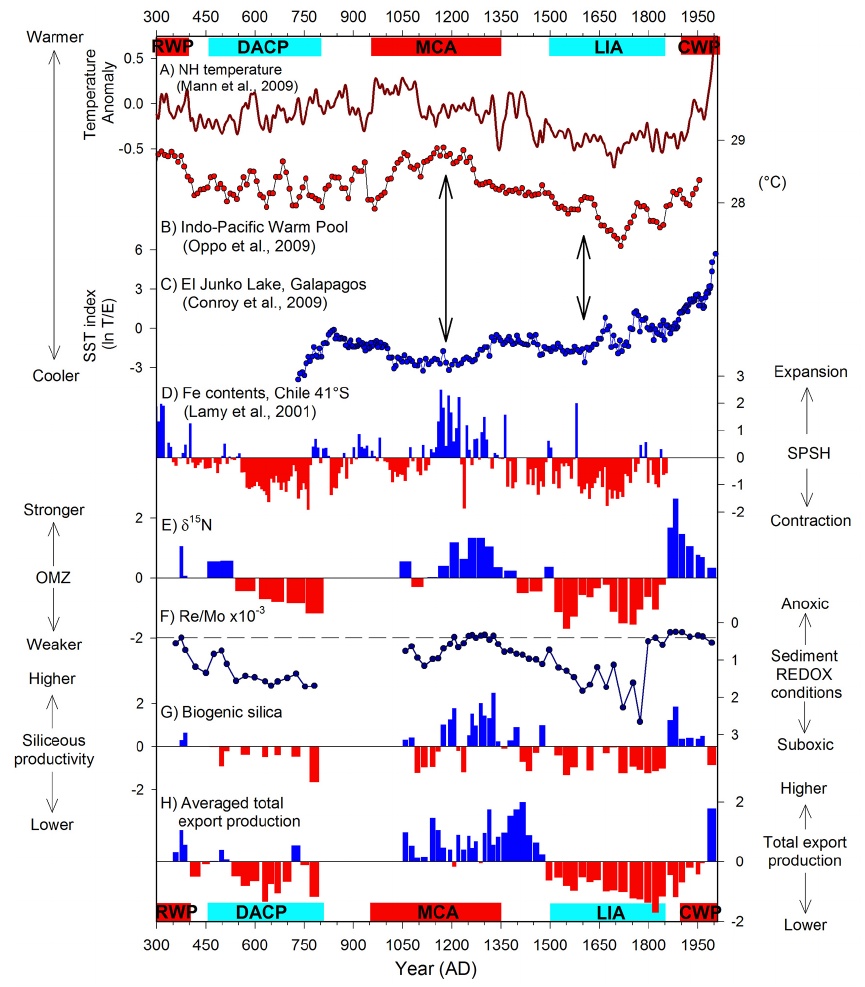
Fig. 4. Linkage between the oxygenation in the subsurface waters and in the sediments, and the export production obtained in the present work and proxies used to infer changes in the zonal SST gradients and changes in the expansion/contraction of the South Pacific subtropical High (SPSH). (A) 10-point average of the “Northern Hemisphere land error-in-variable (EIV) composite” (Mann et al., 2009). (B) Indo Pacific Warm Pool SST reconstruction (Oppo et al., 2009). (C) Eastern Equatorial Pacific SST reconstruction (ln of the number of tychoplanktonic to epiphytic diatoms in El Junco Lake, Galapagos; Conroy et al., 2009). The arrows between these two panels show the increased SST gradient during the MCA compared to the LIA (Conroy et al., 2010). (D) 3-point average of Fe intensity in a marine sediment core off Chile ( ∼ 41 ◦ S), where higher (lower) values indicate a more poleward (equatorward) position of the westerlies. Relative low iron contents are related to enhanced runoff from the iron-poor coastal ranges when the westerlies were positioned over the core position (Lamy et al., 2001). Consequently, a more poleward (equatorward) position of the southern westerlies and the south rim of the SPSH are interpreted to represent a SPSH expansion (contraction). (E) δ 15 N, proxy for water column denitrification. (F) Re/Mo × 10 − 3 , proxy to differentiate euxinic ([O 2 ]=0; presence of H 2 S) versus sub-oxic conditions, the dashed line indicates the seawater value of Re/Mo=0.4 × 10 − 3 reported by Crusius et al. (1996). (G) Biogenic silica (%), proxy for siliceous export production. (H) Averaged total export production obtained from the standardized Ni and Cu values. The colored boxes at the top and bottom of the figure indicate the Roman Warm Period (RWP), the Dark Ages Cold Period (DACP), the Medieval Climate Anomaly (MCA), the Little Ice Age (LIA) and the Current Warm Period